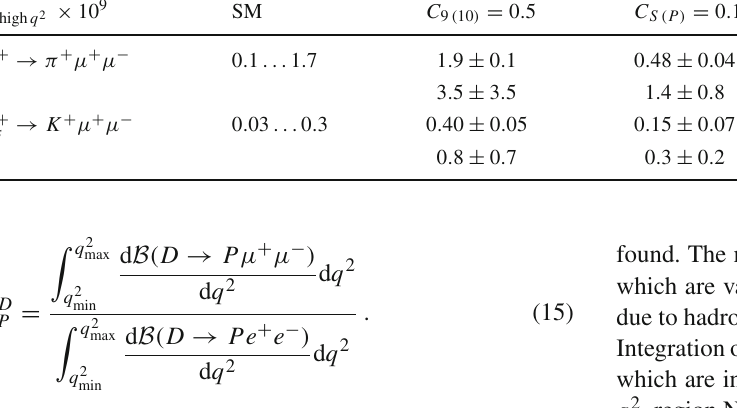
Table 2 Integrated branching fractions in the high q 2 –bin ( third to sixth column, upper entries correspond to NP-only branching ratios while for the lower entries the resonance contributions are taken into account × 10 9 SM C B | high q 2